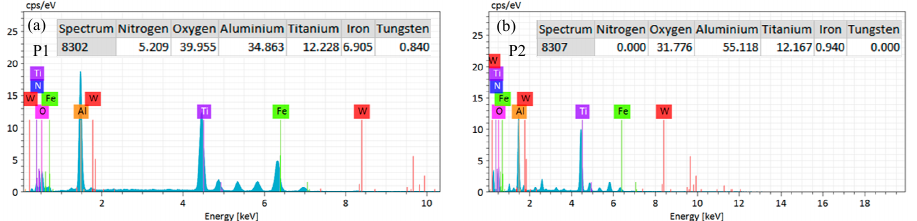
Figure 20. ( a ) EDS analysis point P1 of Tool B in Figure 18. ( b ) EDS analysis point P2 of Tool B in Figure 18.